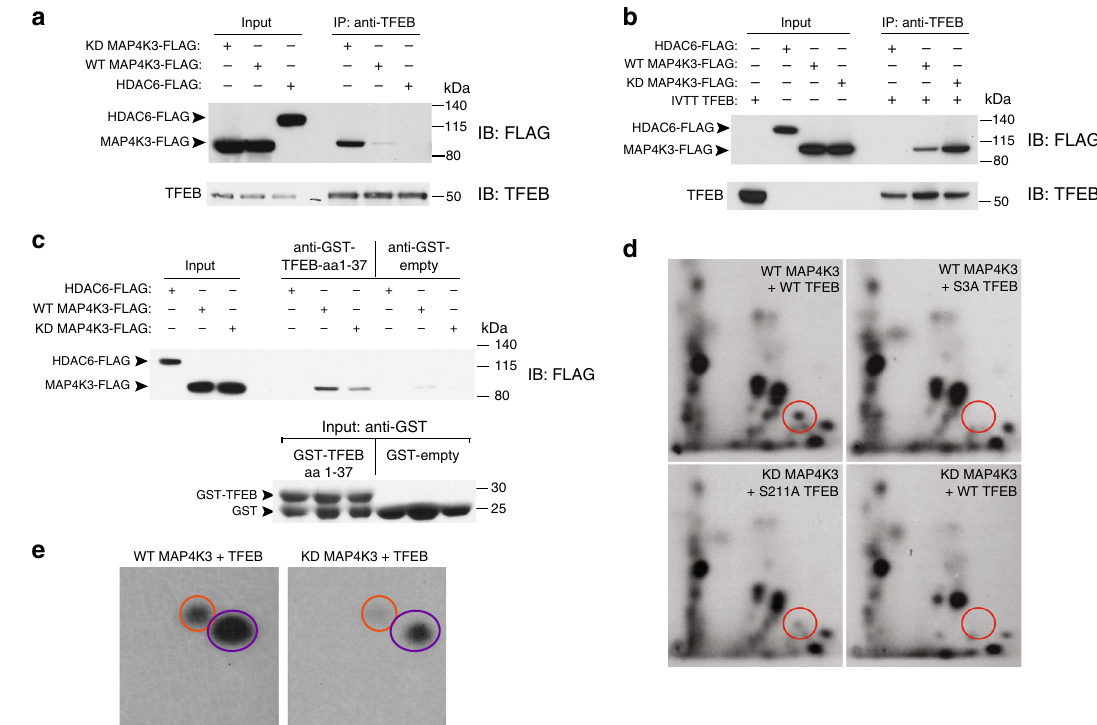
Fig. 5 MAP4K3 phosphorylates TFEB on serine 3. a MAP4K3 physically interacts with TFEB. WT HEK293A cells were transfected with an expression vector for either kinase dead (KD)-MAP4K3-FLAG, WT-MAP4K3-FLAG, or HDAC6-FLAG, and cell lysates and FLAG immunoprecipitates were subjected to immunoblotting. b MAP4K3 directly interacts with TFEB. WT HEK293A cells were transfected with an expression vector for either HDAC6-FLAG, WT- MAP4K3-FLAG, or kinase dead (KD)-MAP4K3-FLAG, and FLAG immunoprecipitates were incubated with recombinant TFEB generated by in vitro transcription and translation (IVTT TFEB). Cell lysates and TFEB immunoprecipitates were then subjected to immunoblotting. c MAP4K3 directly interacts with the N-terminal 37 amino acids of TFEB. WT HEK293A cells were transfected with an expression vector for either kinase dead (KD)-MAP4K3-FLAG, WT-MAP4K3-FLAG, or HDAC6-FLAG, and FLAG immunoprecipitates were incubated with recombinant GST-TFEB amino acids 1-37 or recombinant GST alone, before mixing with GST-containing beads. Cell lysates and the eluate obtained from GST-bound fractions were subjected to anti-FLAG and anti-GST immunoblotting, as indicated. d MAP4K3 phosphorylates TFEB at serine 3. WT HEK293A cells were transfected with WT-MAP4K3-FLAG or KD- MAP4K3-FLAG, and either TFEB-FLAG, TFEB-S3A-FLAG, or TFEB-S211A-FLAG, as indicated. FLAG immunoprecipitates were subjected to in vitro kinase reactions with γ -P 32 -ATP, with Torin1 and the general kinase inhibitor FSBA included in the reaction mixture. Phosphopeptide mapping was performed after enzymatic digestion with thermolysin by spotting the resulting peptide mix onto cellulose thin layer chromatography plates, followed by 2D gel electrophoresis and chromatography, and fi nally autoradiography to visualize phospho-labeled peptides. Circles indicate location of phospho-S3-TFEB. Note the absence of phospho-S3-TFEB for TFEB-S3A and for kinase-dead (KD) MAP4K3. e MAP4K3 heavily phosphorylates TFEB on serines and threonines. WT HEK293A cells were transfected with WT-MAP4K3-FLAG or KD-MAP4K3-FLAG, and TFEB-FLAG, as indicated. FLAG immunoprecipitates were subjected to in vitro kinase reactions with γ -P 32 -ATP, and phospho-amino acid mapping performed by matching the resultant spots on the autoradiograph with ninhydrin-stained standards. Orange circles indicate phospho-serine, and purple circles indicate phospho-threonine. All experiments were performed